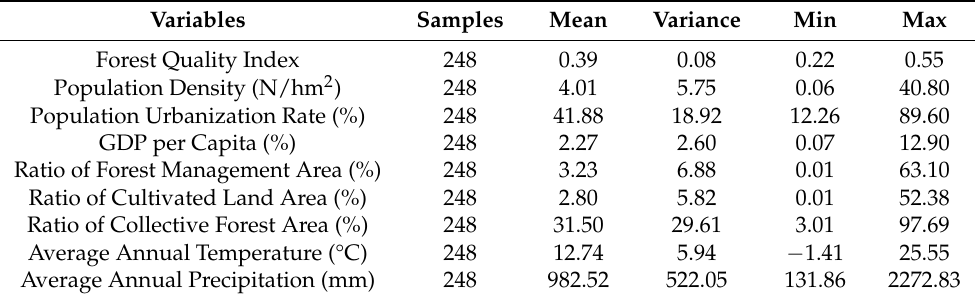
Table 2. Variables applied in the model and basic statistics from 1977 to 2018 in China.